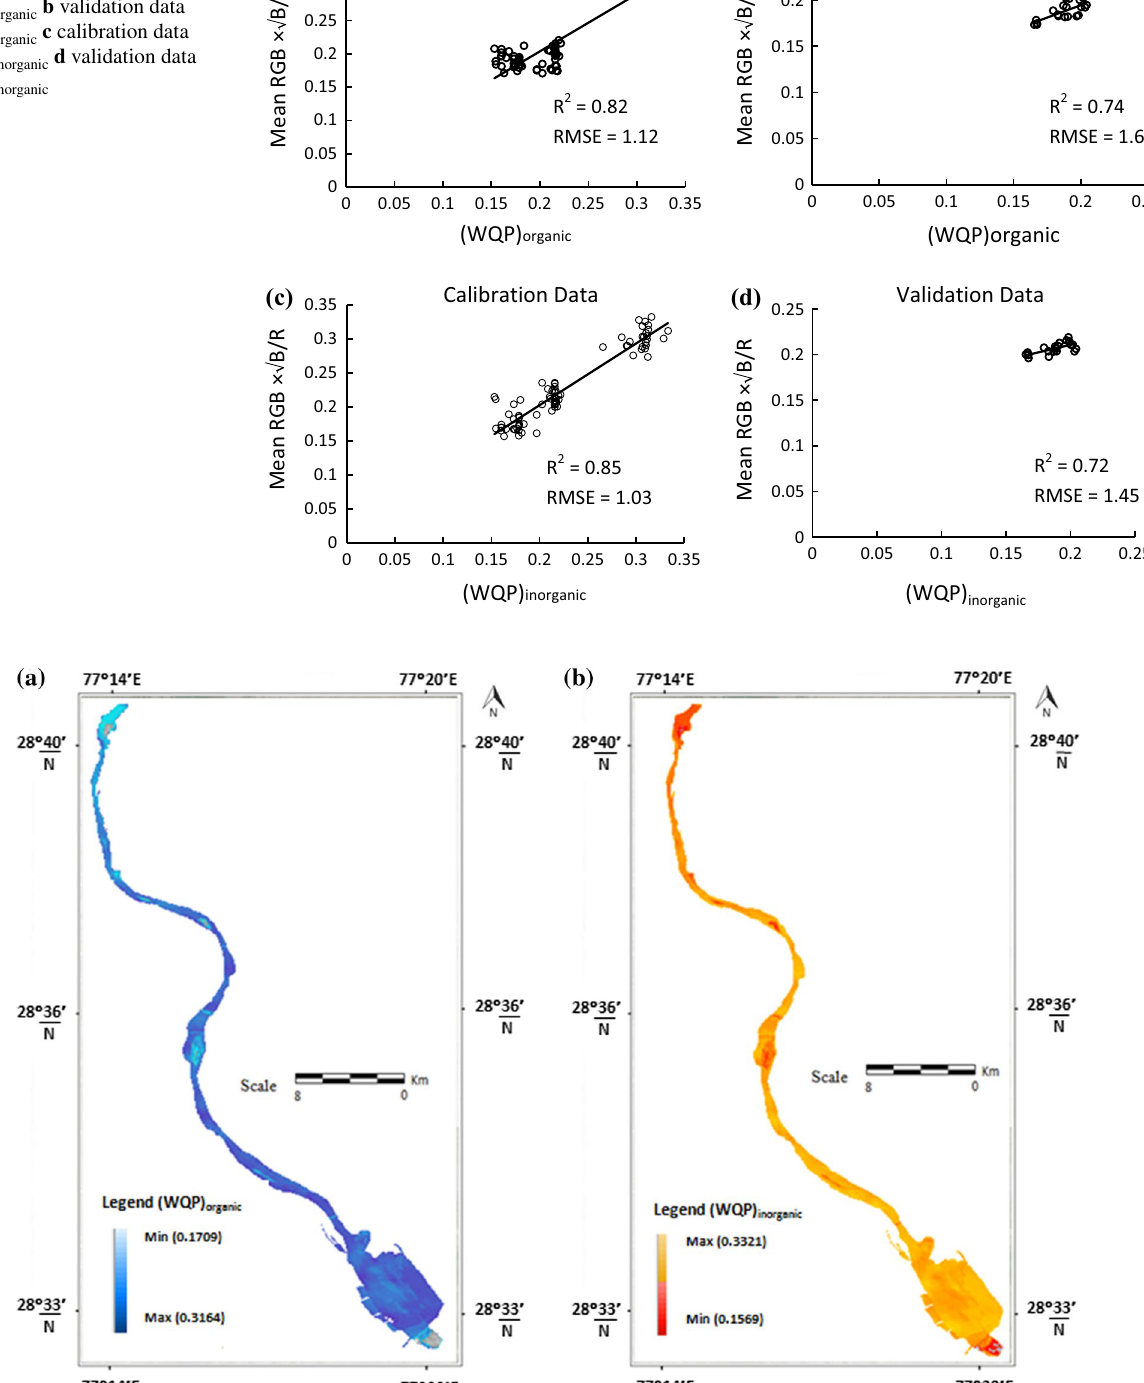
Fig. 4 WQP maps of the study area: a (WQP)